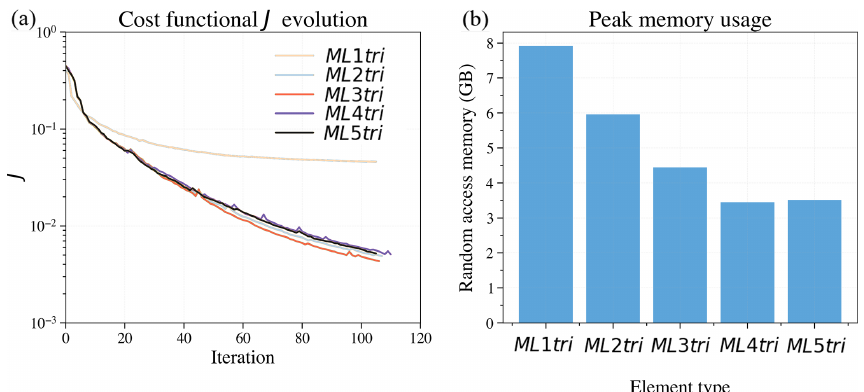
Figure 17. Comparing the performance of FWIs computed with different ML elements. Panel (a) shows the cost functional evolution, and panel (b) shows the peak memory usage.